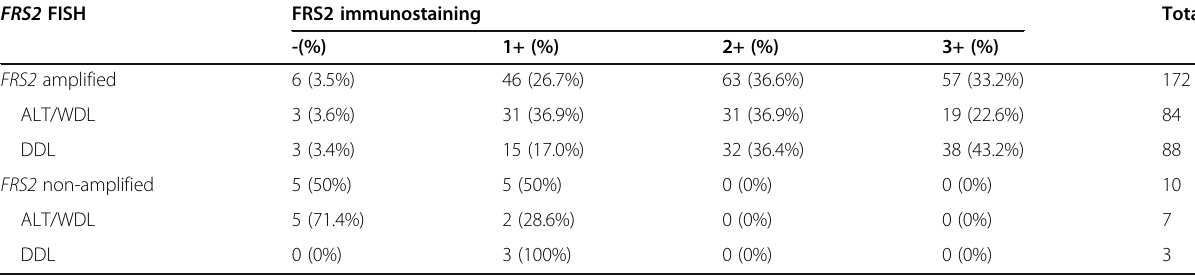
Table 2 FRS2 immunostaining and FISH results in 91ALT/WDLs and 91 DDLs